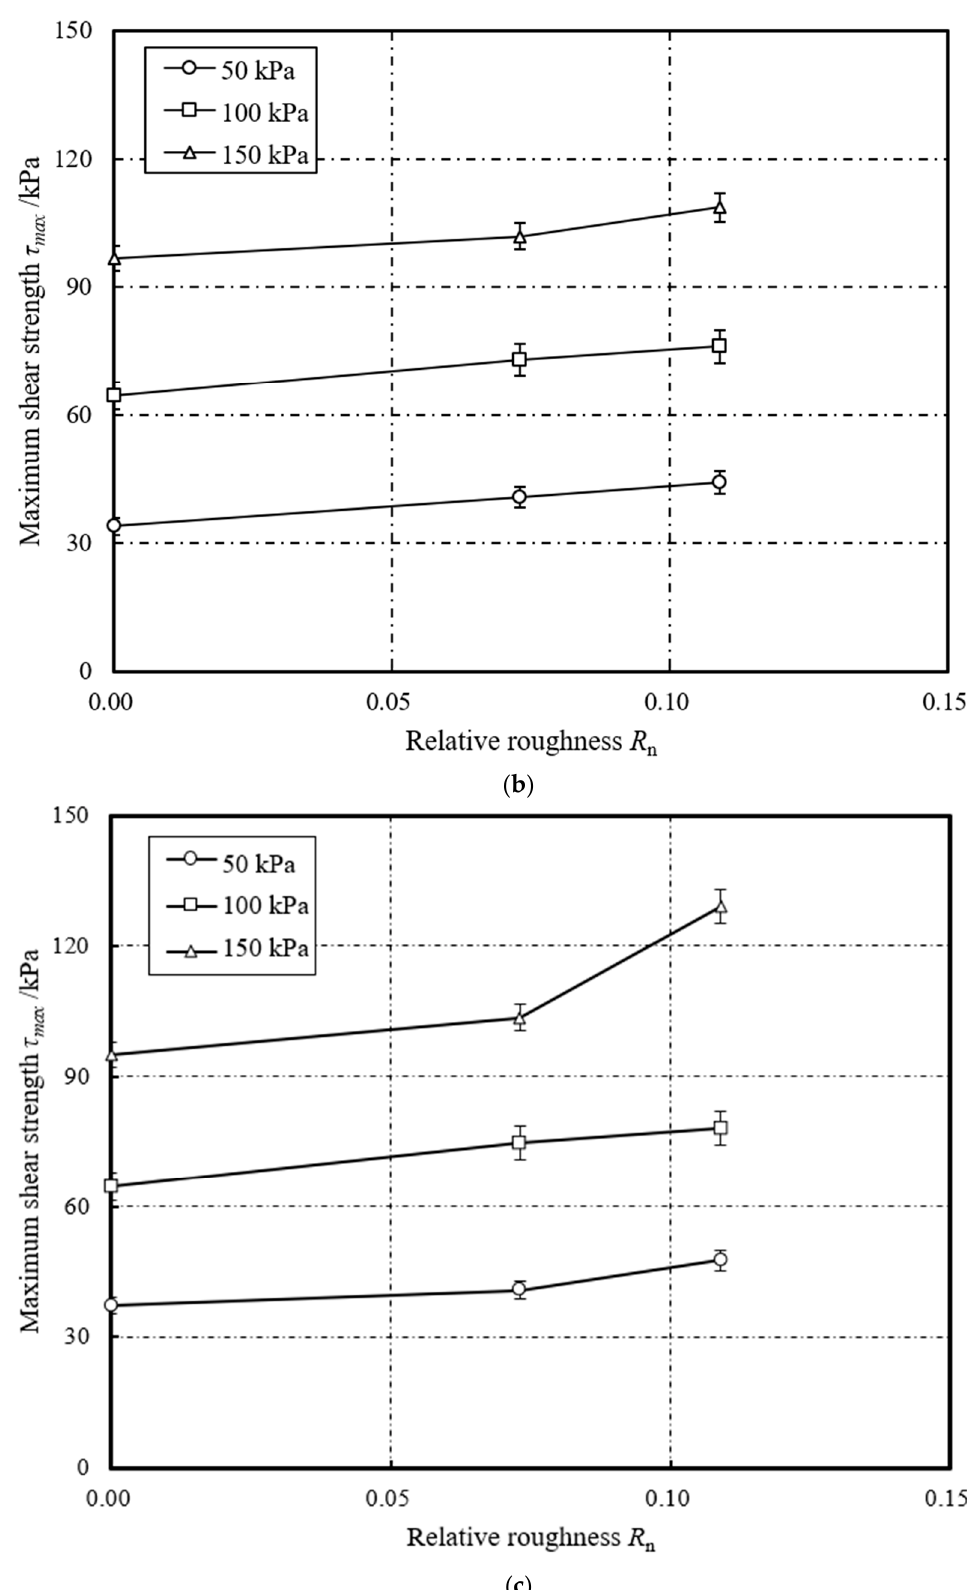
Figure 7. Relationships between relative roughness ( R n ) and maximum shear stress ( τ max ) under different normal stresses: ( a ) 0.63–1.25 mm sand; ( b ) 1.25–2.50 mm sand; ( c ) 2.50–5.00 mm sand.